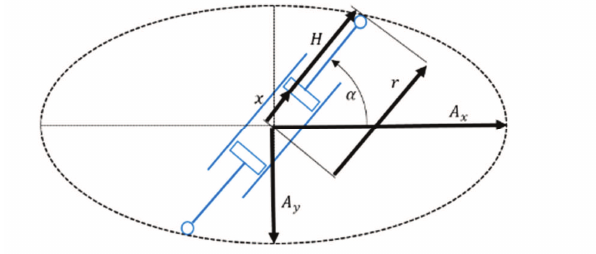
Fig. 8. ERCOP engine scheme